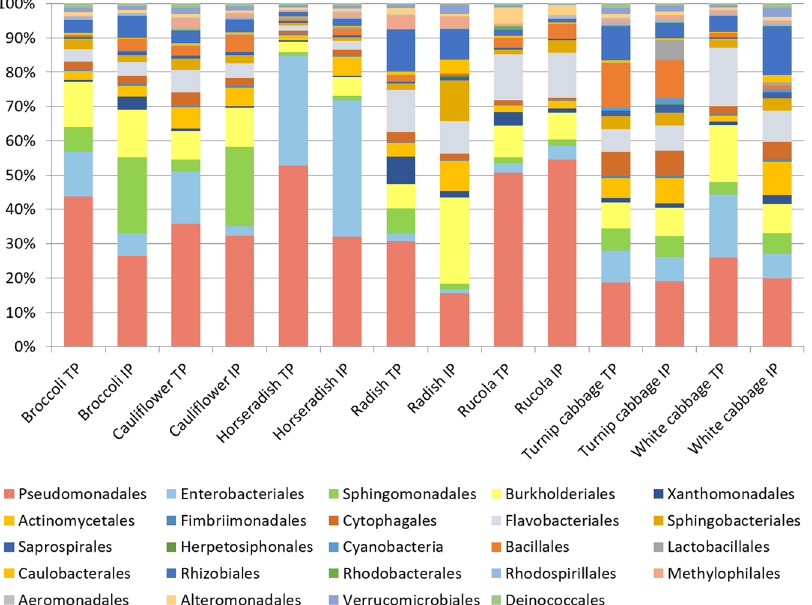
Figure 2. Taxonomic classification of the microbiota inhabiting the processing equivalents of the vegetables types. Bar charts represent the bacterial composition on order level by using a threshold of at least 1% abundance. Abbreviation: TP, traditionally processed; IP, industrially